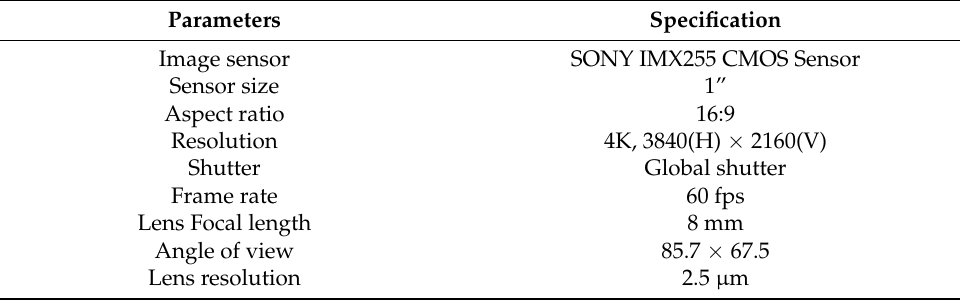
Table 1. DCS camera and lens